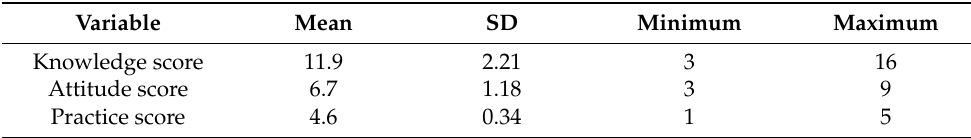
Table 2. Mean knowledge, attitude and practice scores.